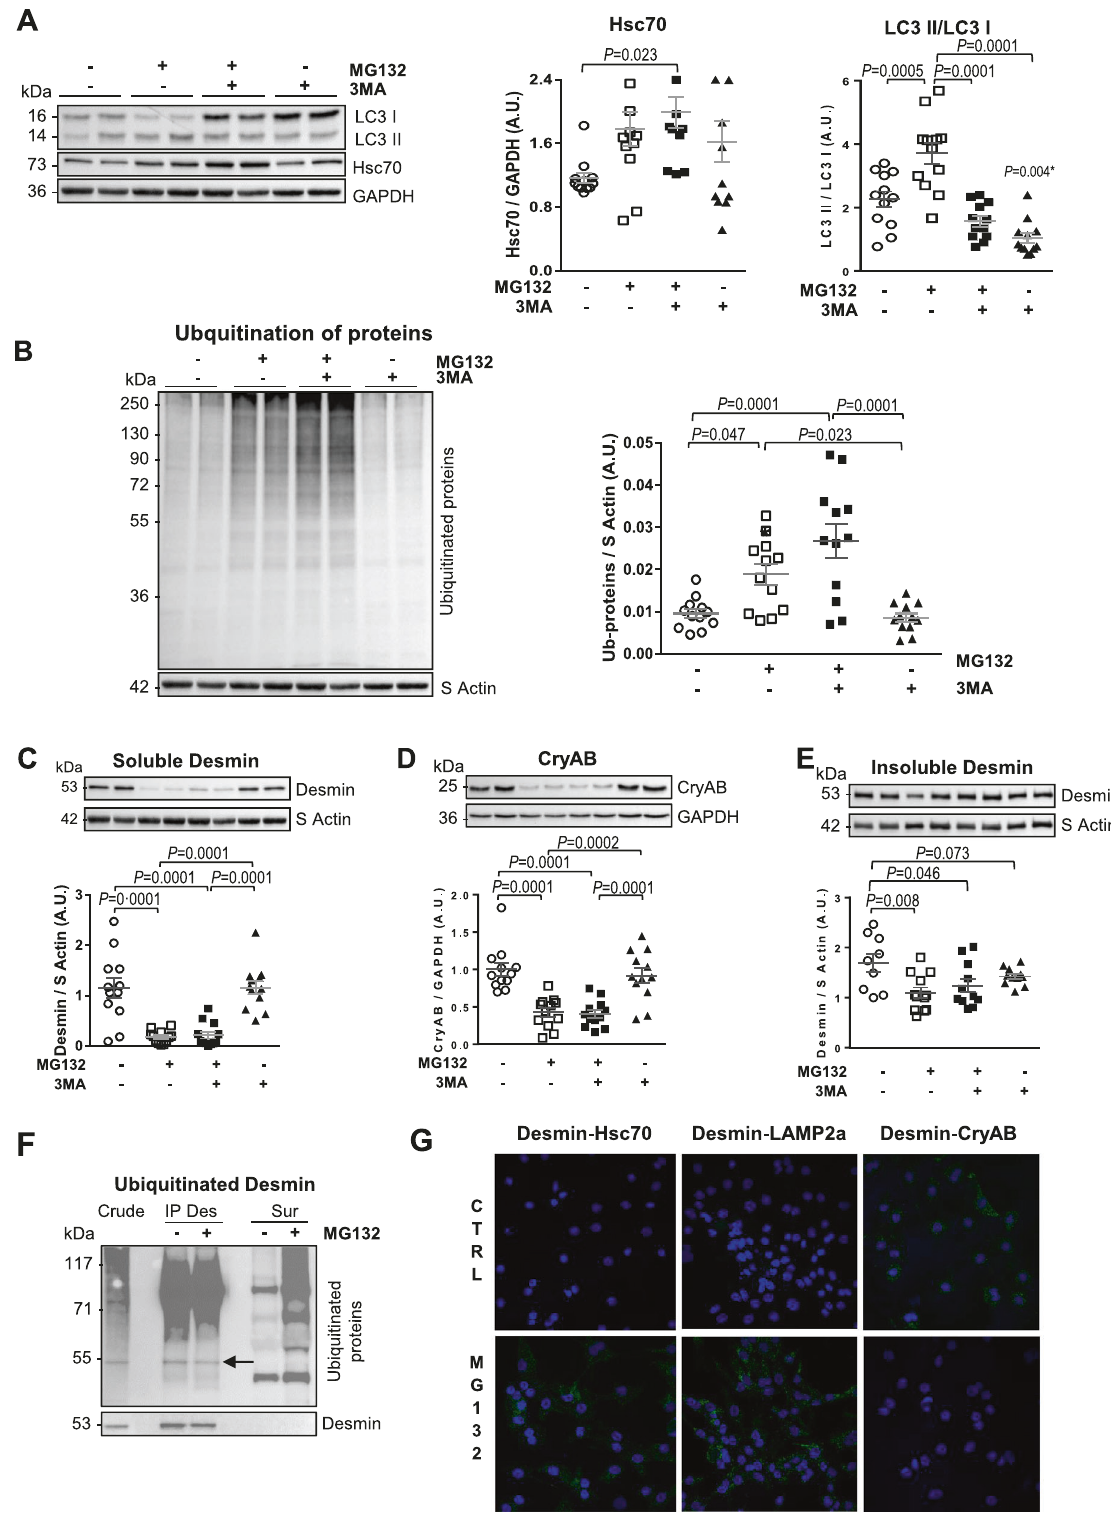
phosphorylation and the chaperone proteins such as CryAB and CMA markers in the failing hearts of patients (Fig. 6 and Fig. S7). Ubiquitination and macroautophagy markers were not modulated as previously described [32]. We found signi fi cantly increased desmin levels with no modulation of CryAB levels in